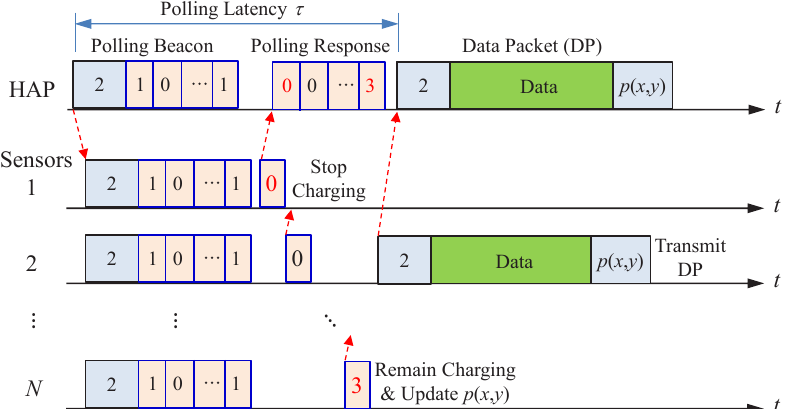
Figure 4. Illustration of the energy-aware polling